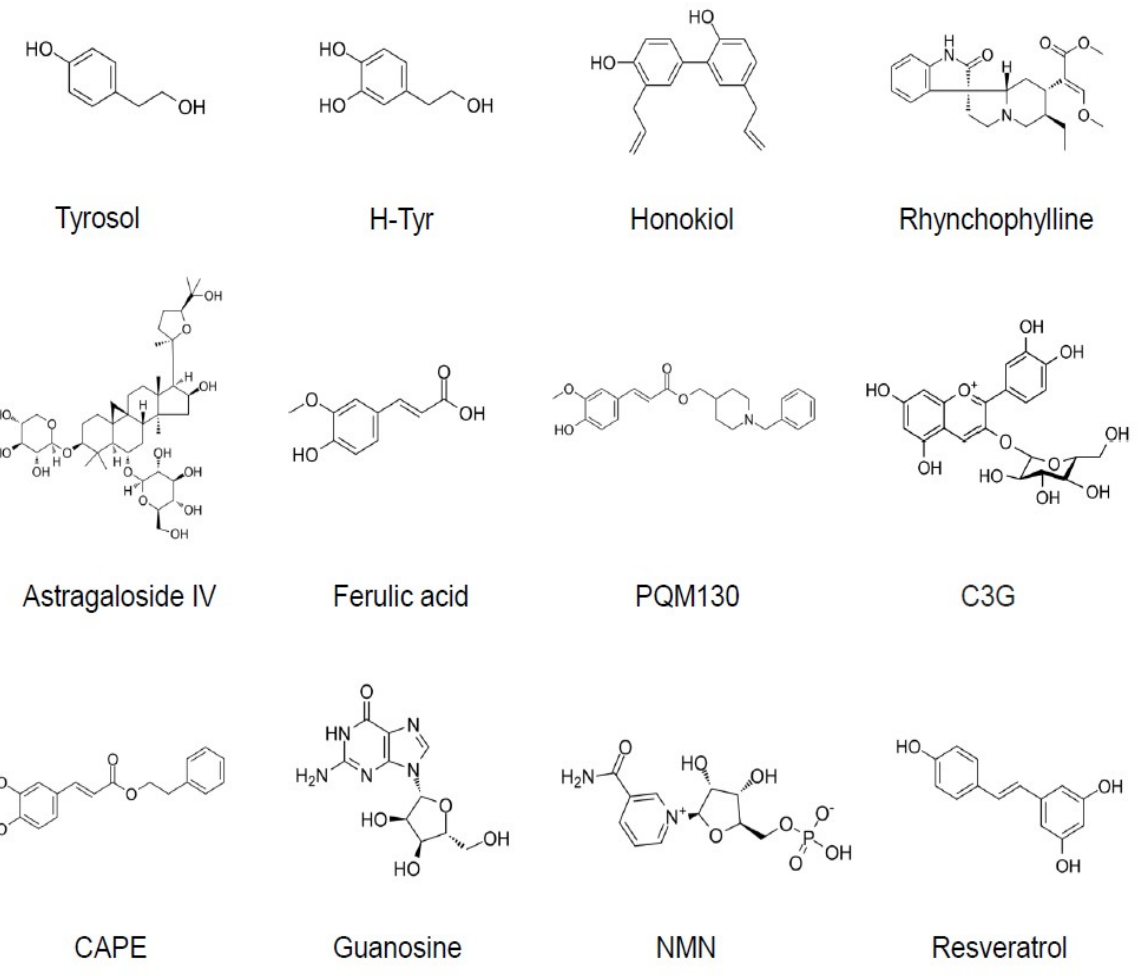
Figure 1. Chemical structures of the small molecules that can reduce A β O neurotoxicity. C3G (cyanidine 3-glucoside) is presented as a representative of anthocyanins. H-Tyr, hydroxytyrosol; CAPE, caffeic acid phenyl ester; NMN, nicotinamide mononucleotide.